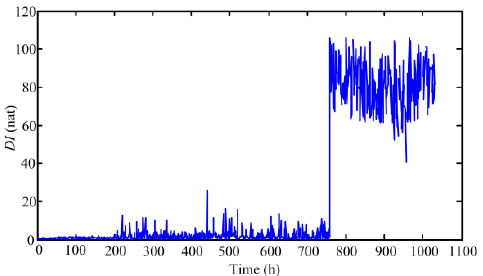
Figure 12. The obtained DI using original 32-dimension features.